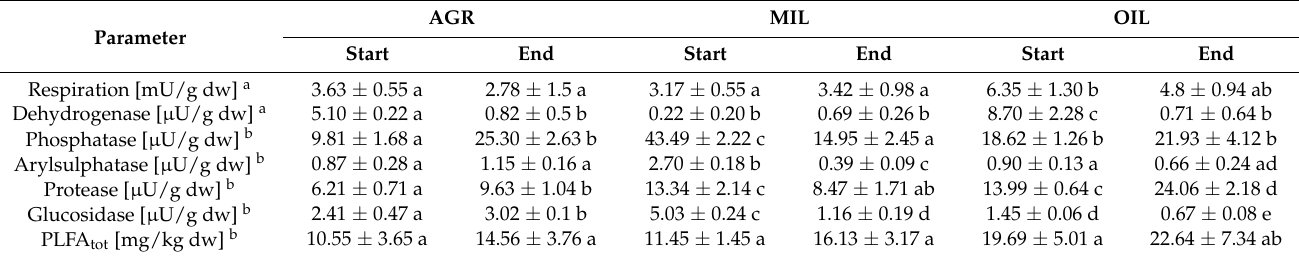
Table 3. Microbial and enzyme activities and microbial biomass (PLFA tot ) (mean ± SD, a n = 8, b n = 4), the same letters behind values mark comparable results ( p < 0.05).